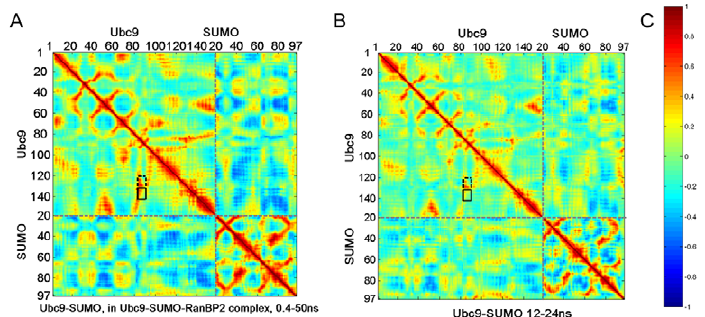
Figure 7. Correlations between fluctuations of residues. (A) Correlations of Ubc9-SUMO from Ubc9-SUMO-RanBP2 overall trajectory. (B) Correlations of Ubc9-SUMO from Ubc9-SUMO trajectory between 12–24 ns of simulation time. In both A and B, the dashed rectangle surrounds the correlations between His83-Ser89 Asn121-Ala131 of Ubc9, the solid rectangle surrounds the correlations between His83-Ser89 and Ala131-Arg141 of Ubc9. (C) The color bar indicating the correlations for both A and